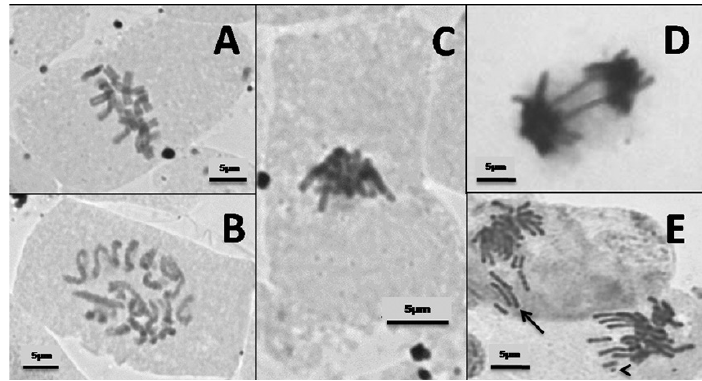
Figure 2 - Mitotic alterations induced by J. curcas oil in